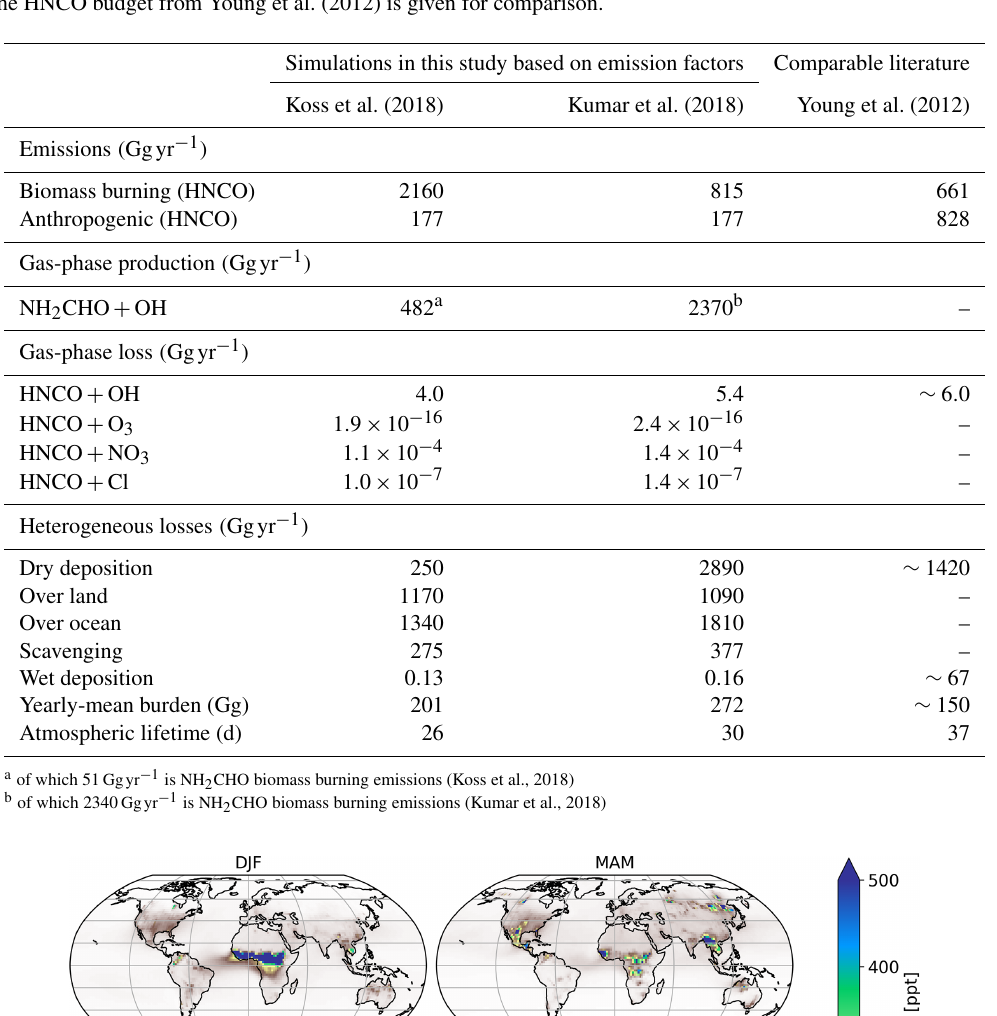
∼ 6 years in that air parcel. The calculated average OH concentration of 1 . 2 × 10 6 moleculecm − 3 in the boundary layer leads to lifetimes towards OH of about 40 years near the surface. For O 3 , Cl, and NO 3 – with maxi- mum oxidant concentrations of 1 . 0 × 10 13 , 7 . 8 × 10 5 , 1 . 5 ×